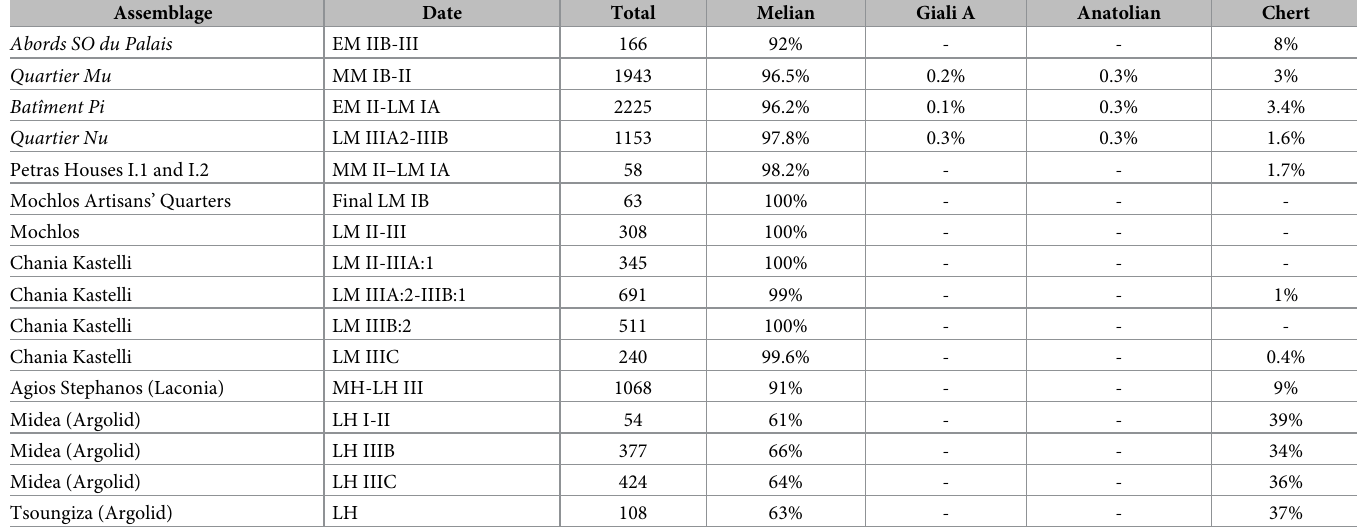
Table 5. Relative proportion of raw materials (obsidian and chert) in a selection of Maliote and later Bronze Age Greek mainland chipped stone assemblages. Abords Sud-Ouest du Palais [132], Quartier Mu [115]; Batîment Pi , Quartier Nu (this paper); Petras [154]; Mochlos [128, 131]; Chania Kastelli [140, 141, 155, 156]; Agios Stephanos [157]; Midea, Tsoungiza [143]. Assemblage